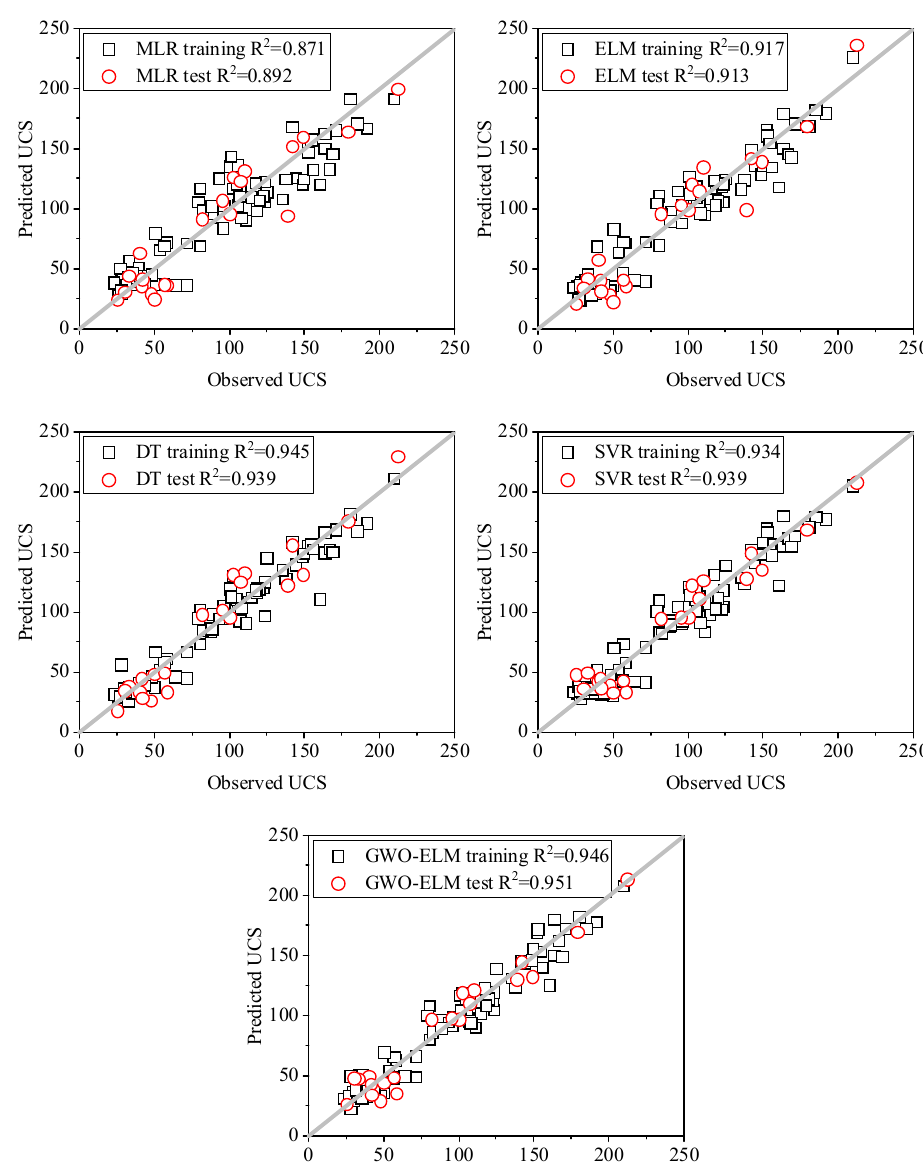
Figure 7. Prediction results of training and test stages for different models for UCS. Further, the distribution of prediction errors for each model is calculated as shown in Figure 8. Then, the relative error for the test set is calculated and plotted in the box plot shown in Figure 9. In addition, the evaluation metrics are listed in Table 2, where for the test set, the hybrid GWO-ELM model achieves an RMSE of 11.446 and a MAPE of 16.131%. This further demonstrates the excellent prediction accuracy of the optimization model suggested in this paper and its ability to capture the nonlinear relationship between the UCS and the four input variables.